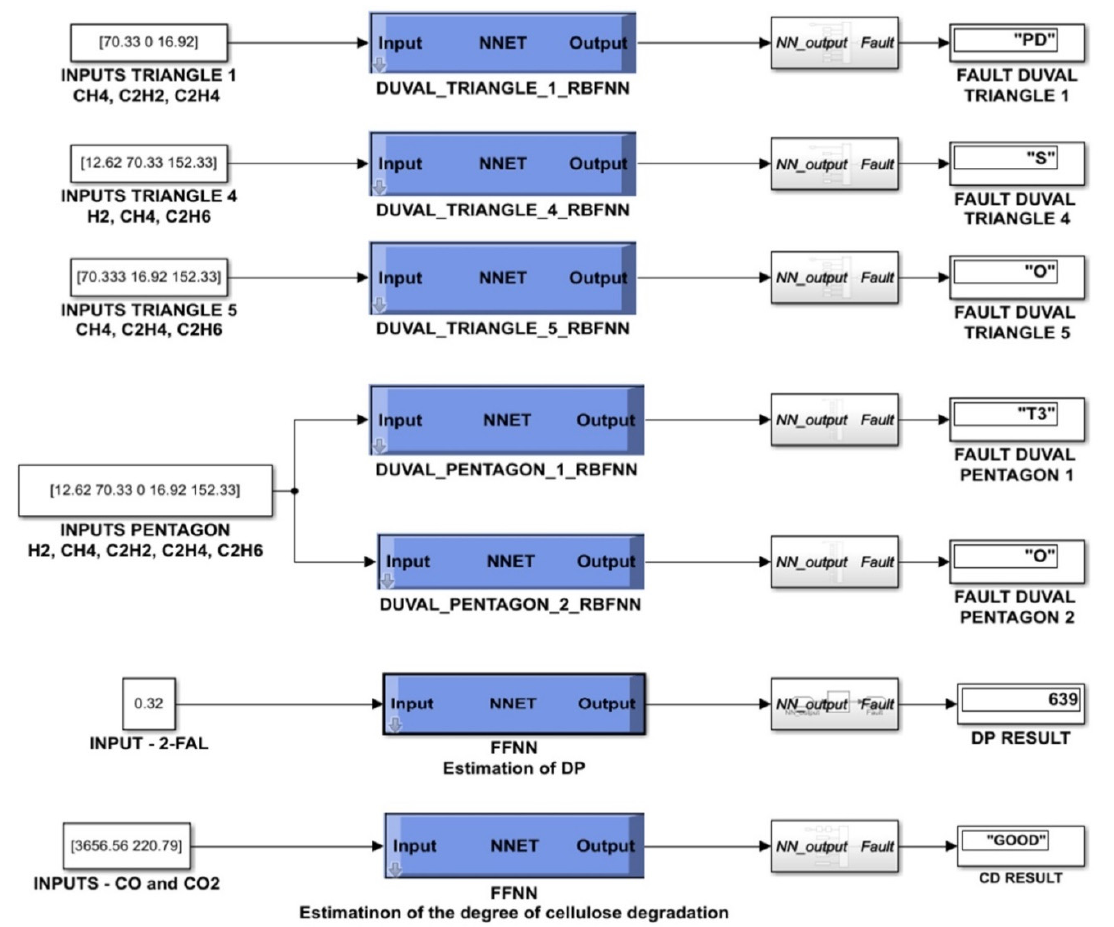
Figure 16. Neural software module of the ISDFPT-NN.